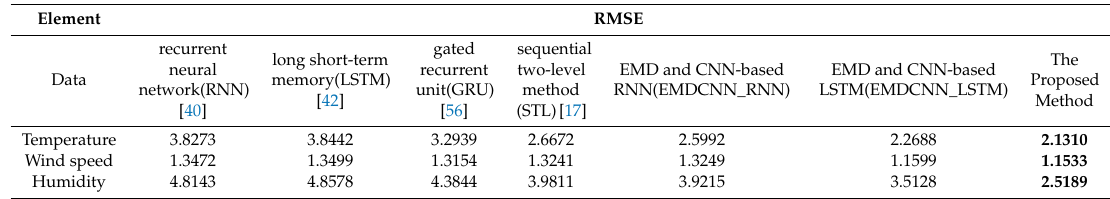
Table 1. Comparison of root mean square error (RMSE) of prediction results with the di ff erent predictors. Element